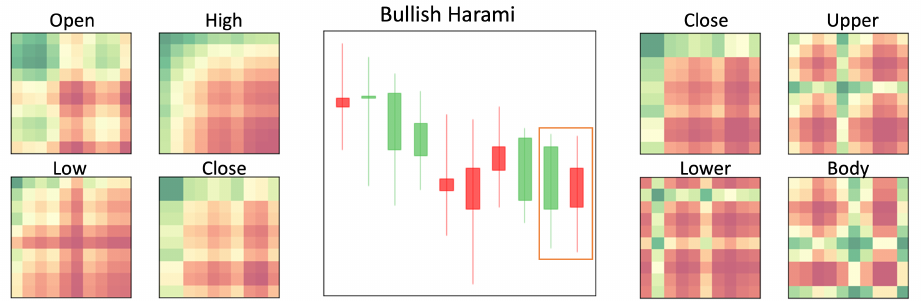
Figure 19. Example of Bullish Harami pattern and GASFs. The middlemost figure is the original candlesticks. The red and green candlesticks represent closing prices are higher than the opening prices are not. The left and right sides are the heatmaps of GASFs. The range of the heatmap is ( − 1,1 ) , where red equals − 1 and green equals 1.